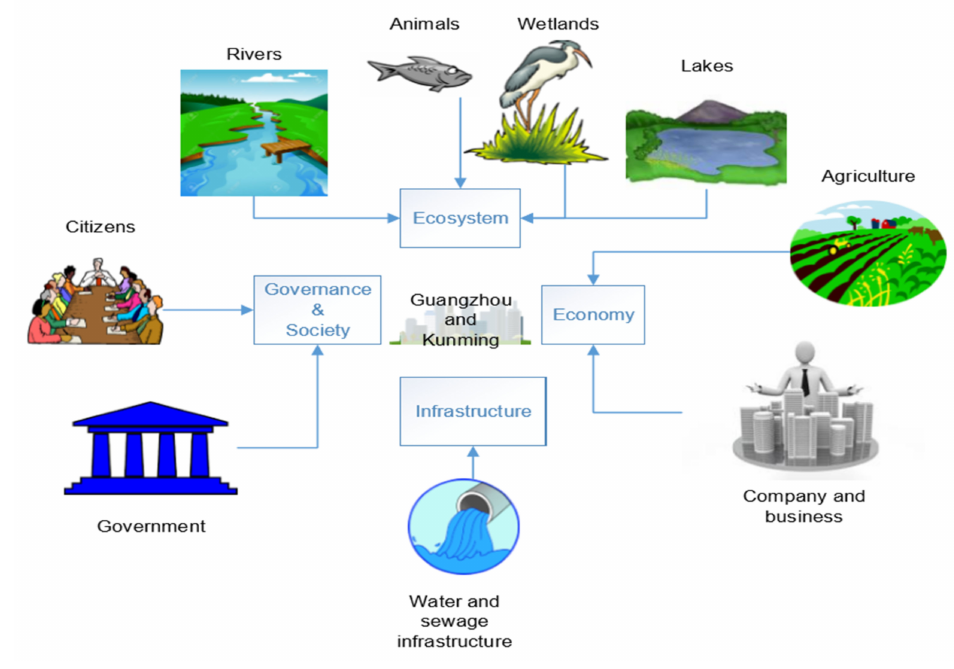
Figure 2. The linkages of urban water management.